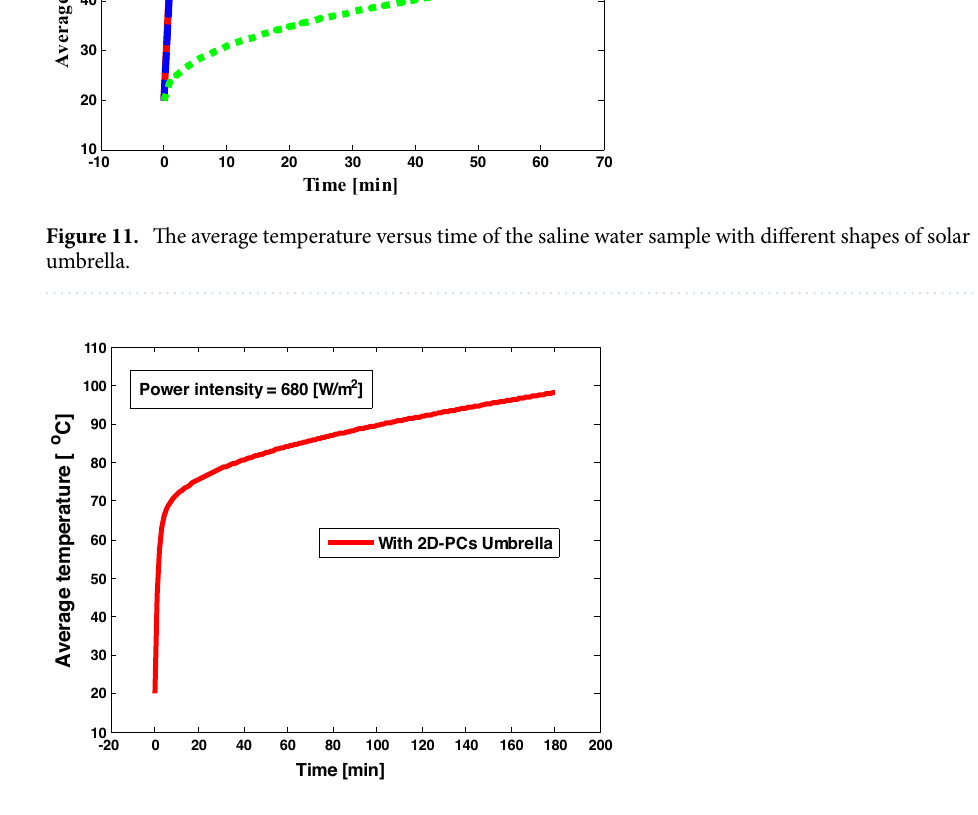
Figure 12. The average temperature versus time of the saline water sample with 2D- PCs solar